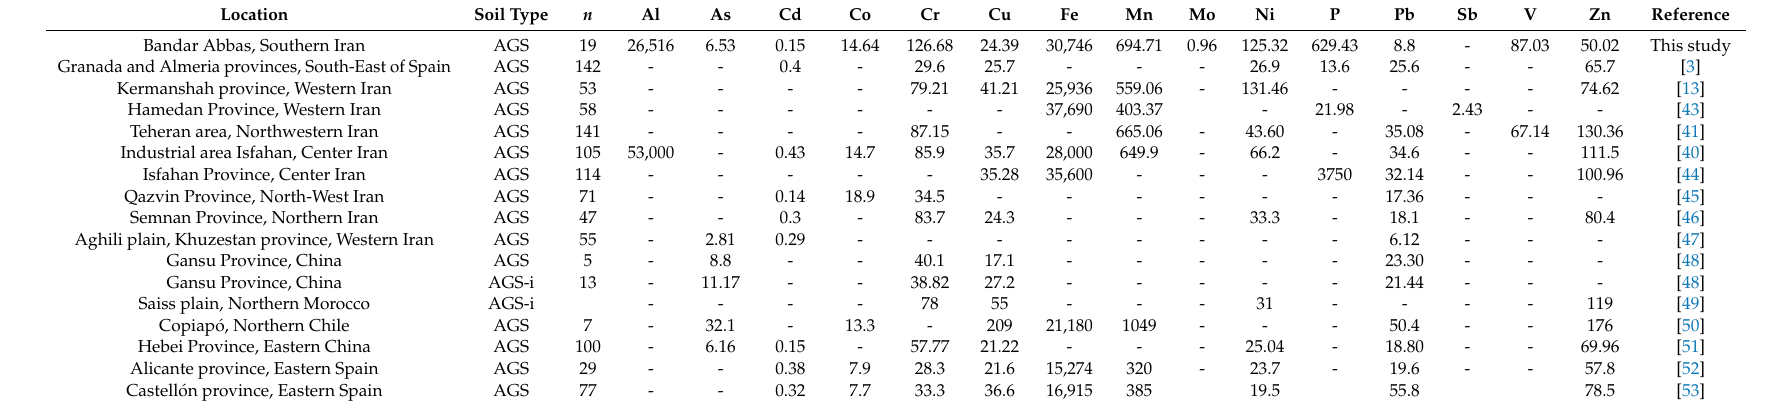
Table 2. Comparison of studied PTE in agricultural soils between the present work and other studies from arid and semiarid environments (mean values, mg · kg − 1 ).